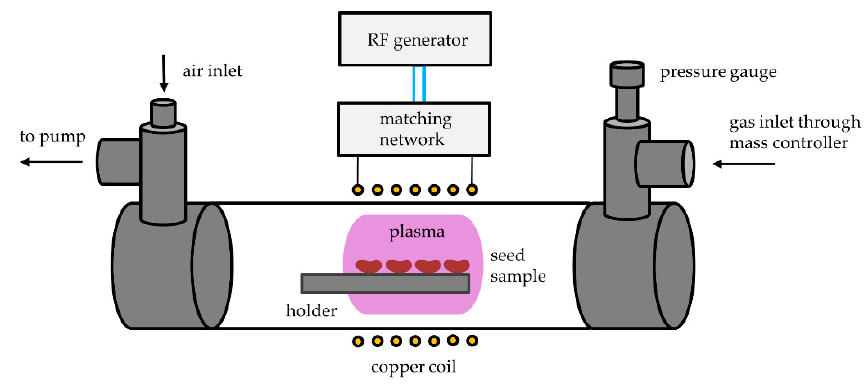
Figure 13. Schematic representation of the plasma system used for the treatment of bean seeds.